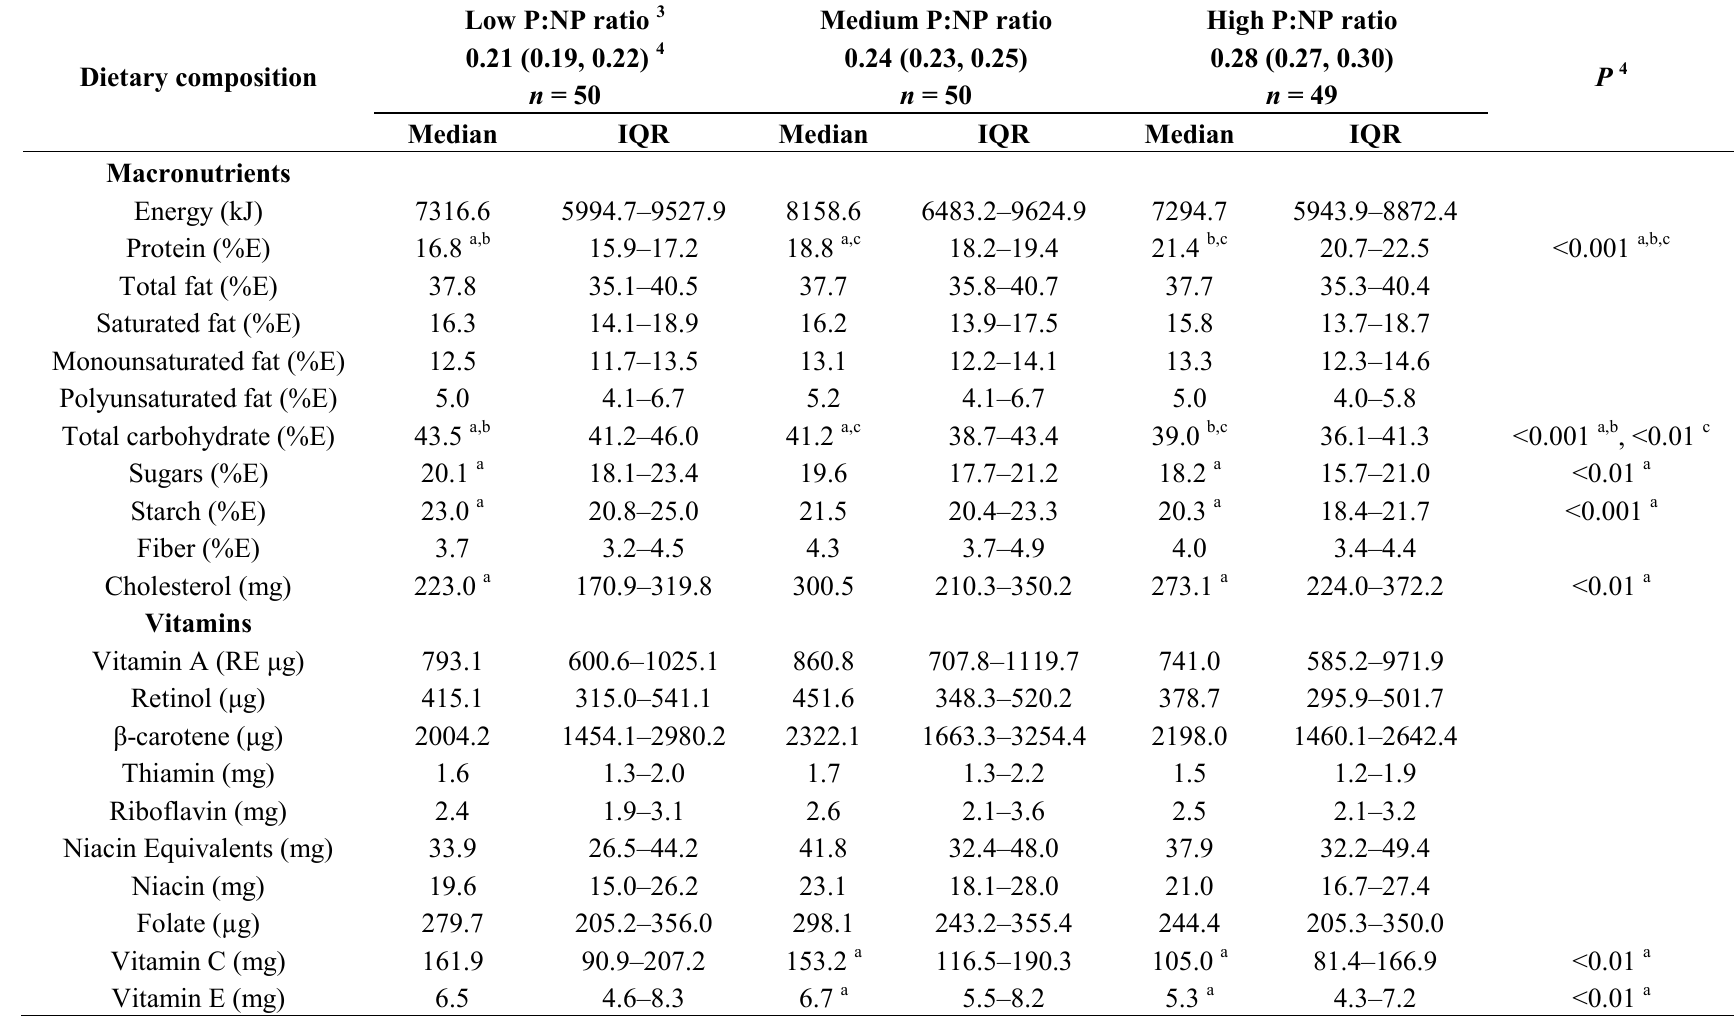
Table 2. Dietary composition during pregnancy for participants in the WATCH Study with plausible dietary data, by tertile of the protein to non-protein ratio ( n = 149) 1,2